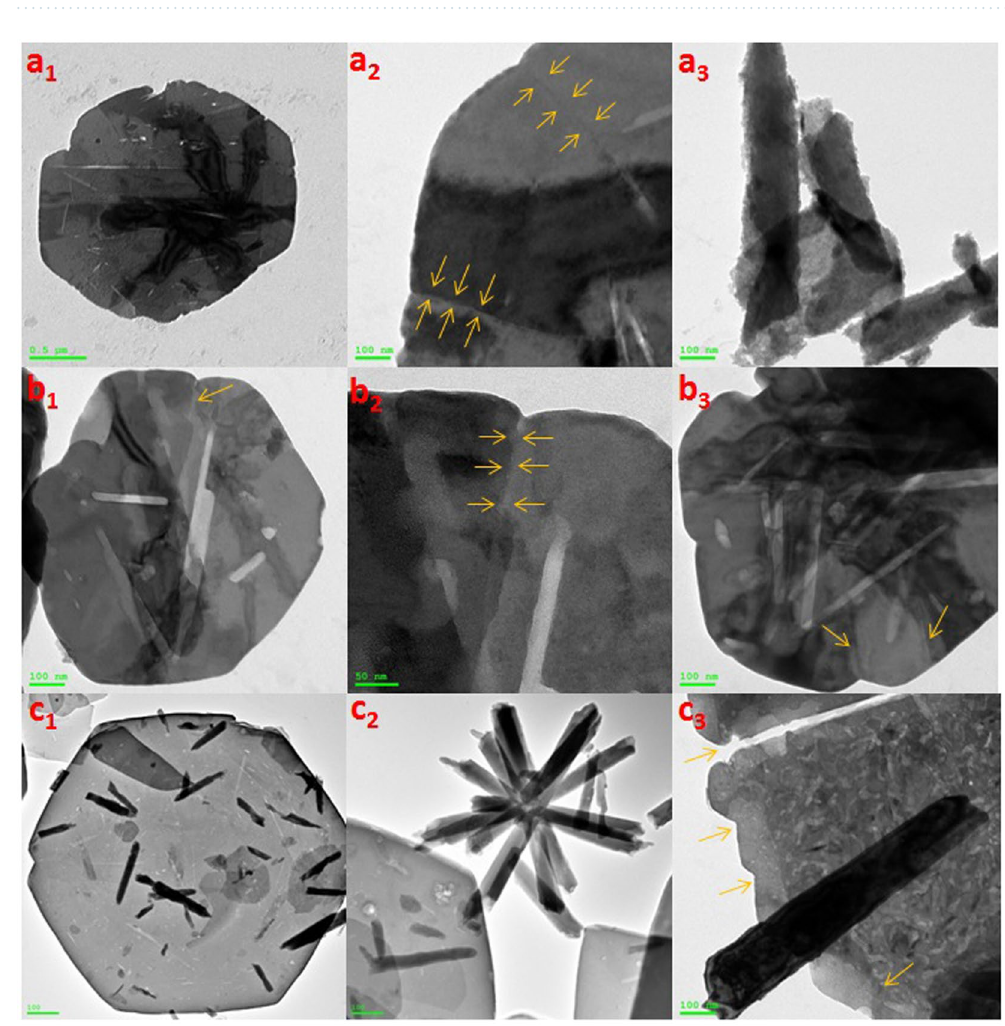
Figure 15. HRTEM of nanoplatelets ( a 1 , a 2 ) with grain boundaries (yellow arrows) and ZnO nanorods are agglomerating to design the decorating ZnO nanostructures ( a 3 ), nanoplatelets with grain boundaries decorated ZnO nanorods ( b 1 , b 2 , and b 3 ), well-shaped nanoplatelets decorated ZnO nanorods and nanoflowers ( c 1 and c 2 ) and disconnected nanoplatelets ( c 3 ) [Samples a, b and c were picked up at 3.5, 8.5, and 15 minutes,